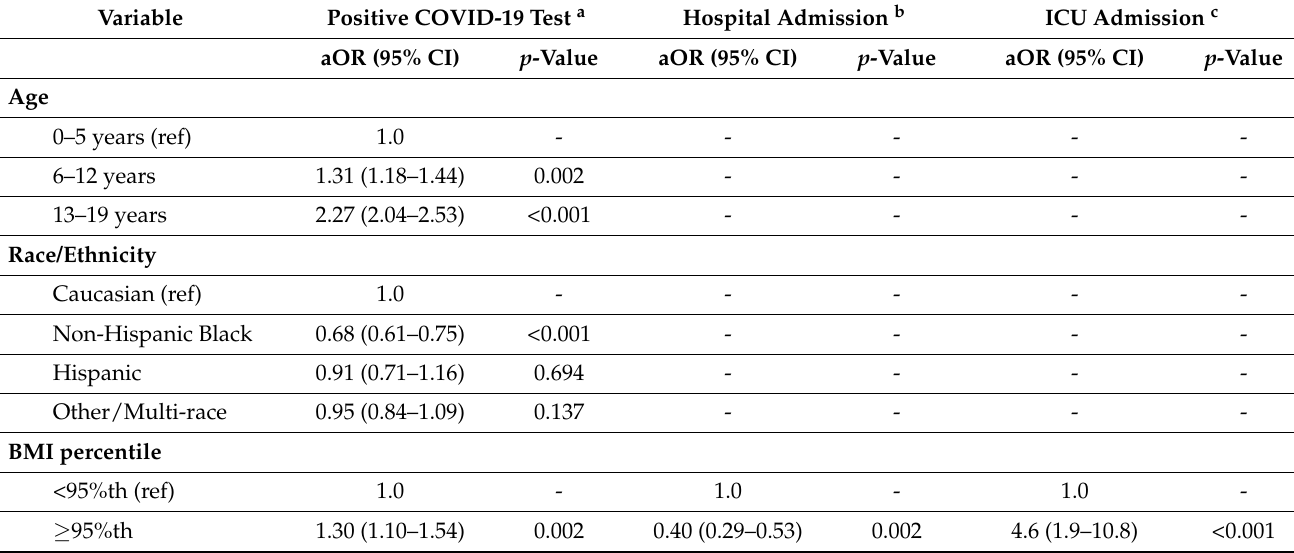
Table 3. Adjusted odds of positive COVID-19 test results, hospital and ICU admission by patient characteristics and